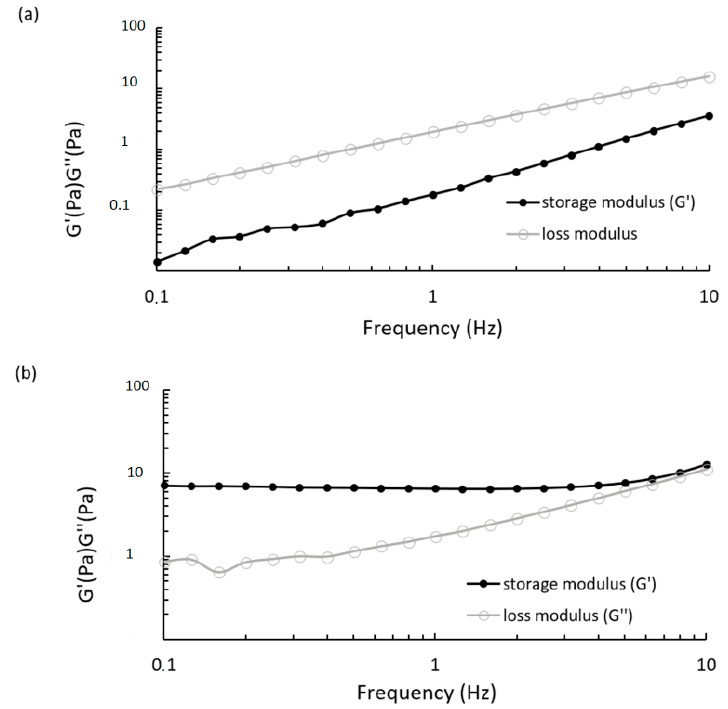
Figure 6. Frequency dependence of storage modulus (G ′ , •) and loss modulus (G ′′ , ○ ) of CS/ β GP at: 25 °C ( a ); and 37 °C ( b ). Each modulus was measured between 0.1 and 10 Hz at stress of 0.1 Pa.